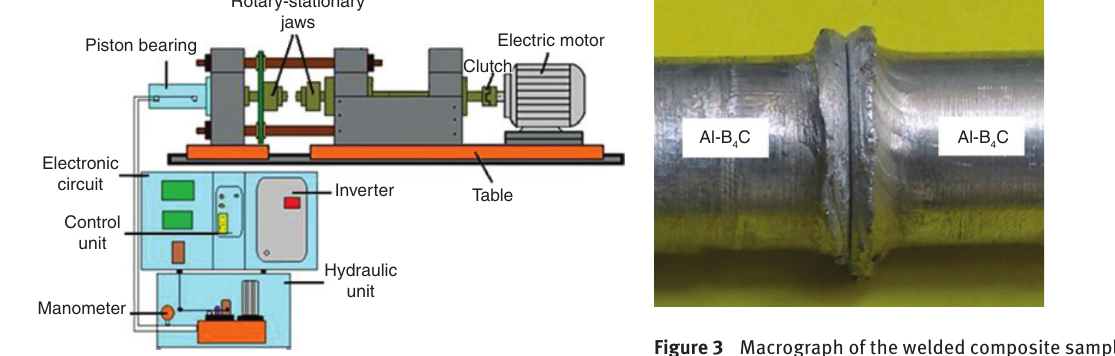
Figure 2 Friction welding machine and parts.